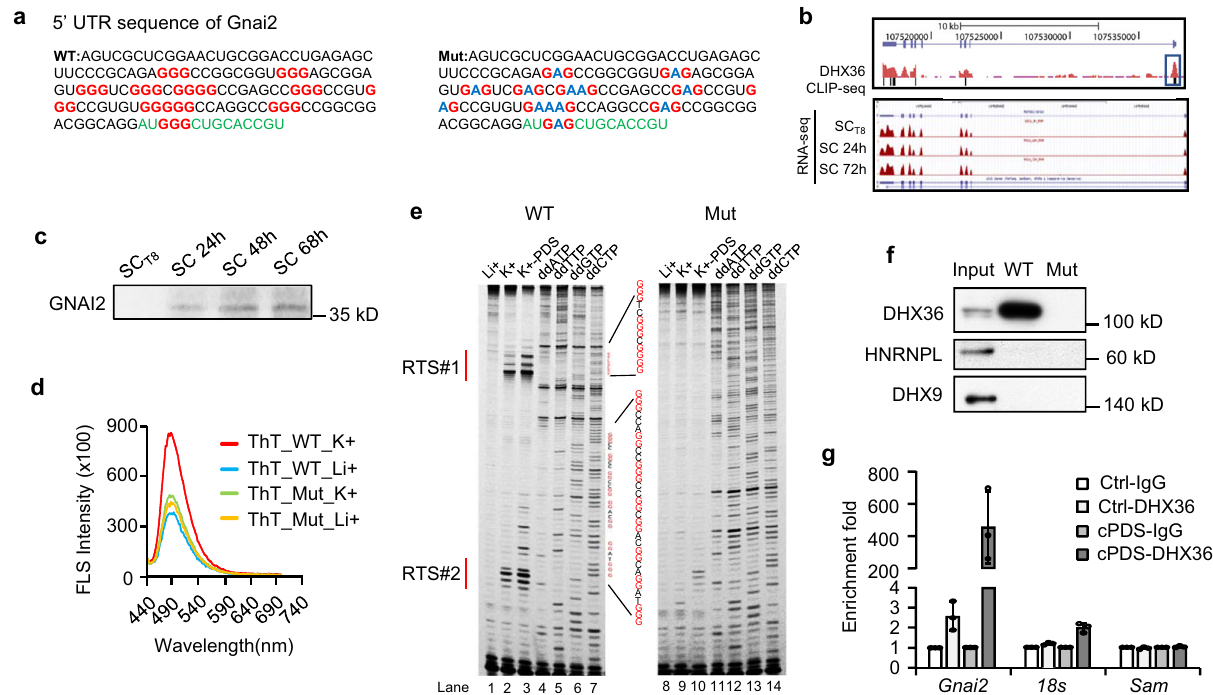
Fig. 7 DHX36 binds to Gnai2 mRNA via the 5 ’ UTR rG4. a Sequence of the WT or mutant (Mut) Gnai2 mRNA 5' UTR. Green color denotes the coding sequence. All GGGs are highlighted in red. Mutated Gs are highlighted in blue. b Top: Genomic snapshot of DHX36 CLIP-seq track showing its binding at Gnai2 mRNA. Bottom: Snapshot of RNA-seq tracks showing Gnai2 mRNA levels in freshly isolated SCs, SCs cultured for 24 or 72 h. c GNAI2 protein levels in SCs cultured for the indicated time points were examined by western blot. d WT or Mut Gnai2 5 ’ UTR RNAs were treated with 150 mM Li + or K + together with 1 µ M ThT and excited at 425 nm. Plot of the intensity of Fluorescent spectrum (FLS) with the wavelength from 440 to 700 nm. Red line: WT RNA treated with K + ; blue line: WT RNA treated with Li + ; green line: Mut RNA treated with K + ; orange line: Mut RNA treated with Li + . e WT or Mut Gnai2 5 ’ UTR RNAs were treated with 150 mM Li + , 150 mM K + , or 150 mM K + plus 2 μ M PDS. Reverse transcriptase was stalled at the rG4 formation site to form reverse stalling site (RTS). The cDNAs generated by the above reverse transcription were run on a Dideoxy sequencing gel. Left: In WT Gnai2 5 ’ UTR RNA, two major RTS (highlighted as RTS #1 and #2) sites were identi fi ed. Right: no RTSs were detected in Mut Gnai2 5 ’ UTR RNA. f RNA pull-down was performed with in vitro transcribed and biotin-labeled WT or Mut Gnai2 5 ’ UTR RNAs and the retrieved DHX36 protein was detected by western blot. HNRNPL and DHX9 were used as negative controls. g C2C12 myoblast cells were treated with Ctrl (same volume of DMSO in the culture medium as cPDS) or 5 μ M cPDS for 24 h and RNA immunoprecipitation (RIP) was performed to detect retrieved Gnai2 transcripts. 18s and Sam transcripts were used as negative controls. Data represent the average of three independent experiments ± s.d. ( g ). Source data are provided as a Source Data fi